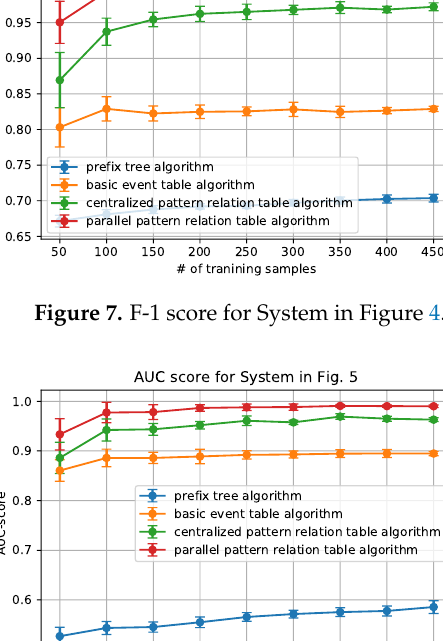
prefix tree algorithm basic event table algorithm centralized pattern relation table algorithm parallel pattern relation table algorithm